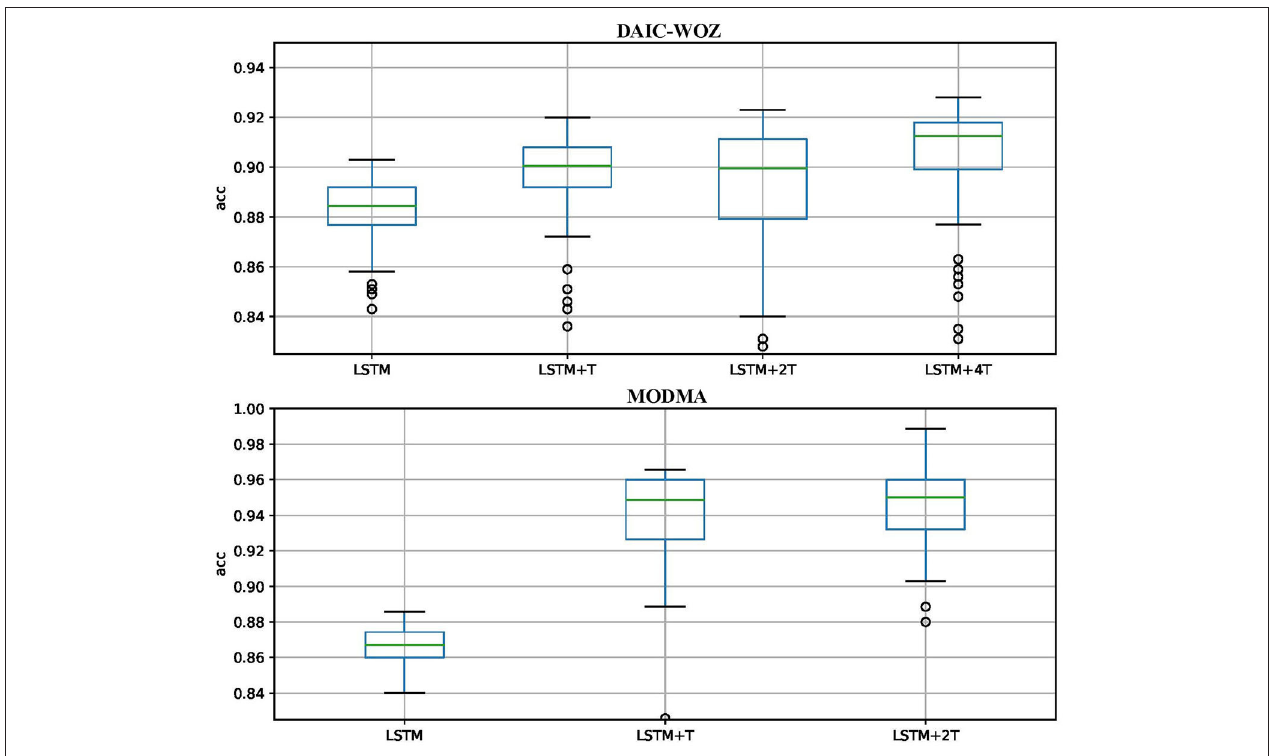
FIGURE 6 | Stability of models on test